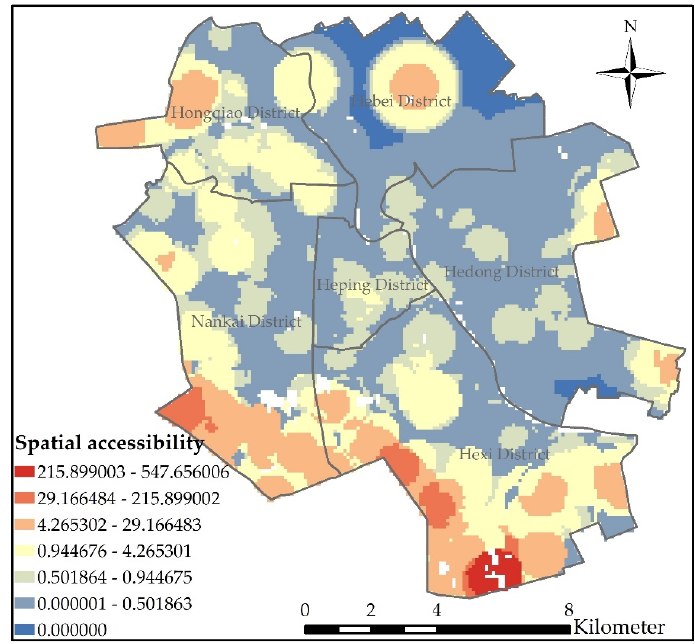
Figure 8. Spatial accessibility distribution calculated by FC2SFCA method.